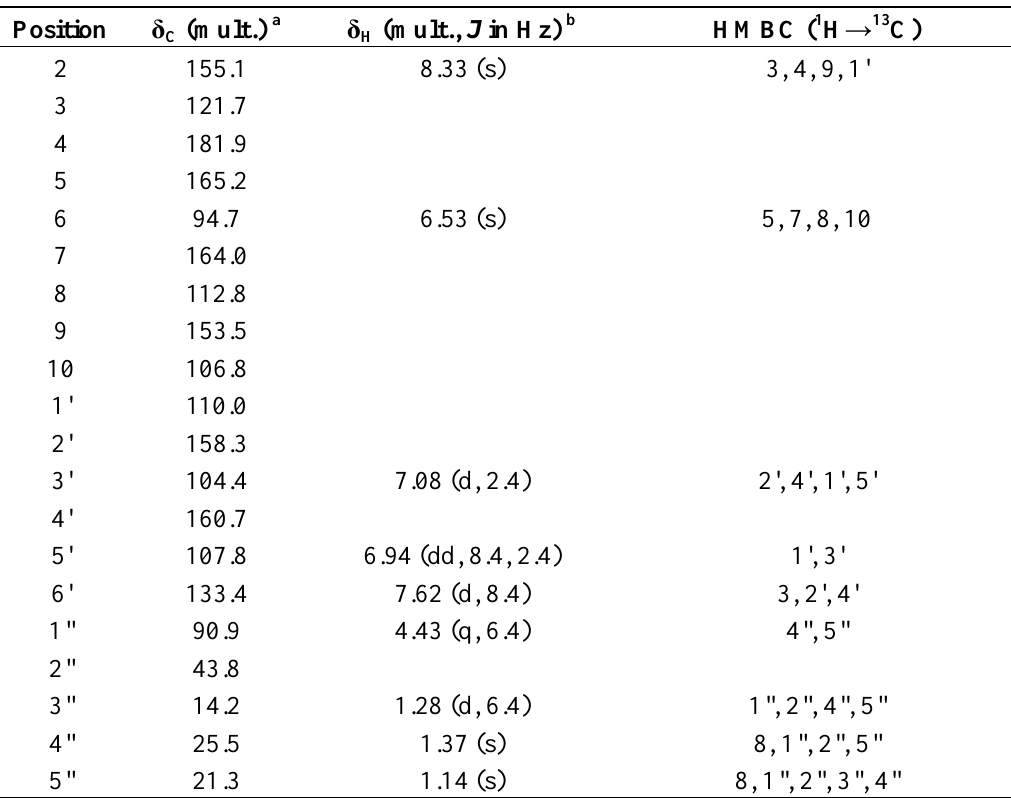
Table 1. 13 C, 1 H and HMBC data for fleminigin ( 1